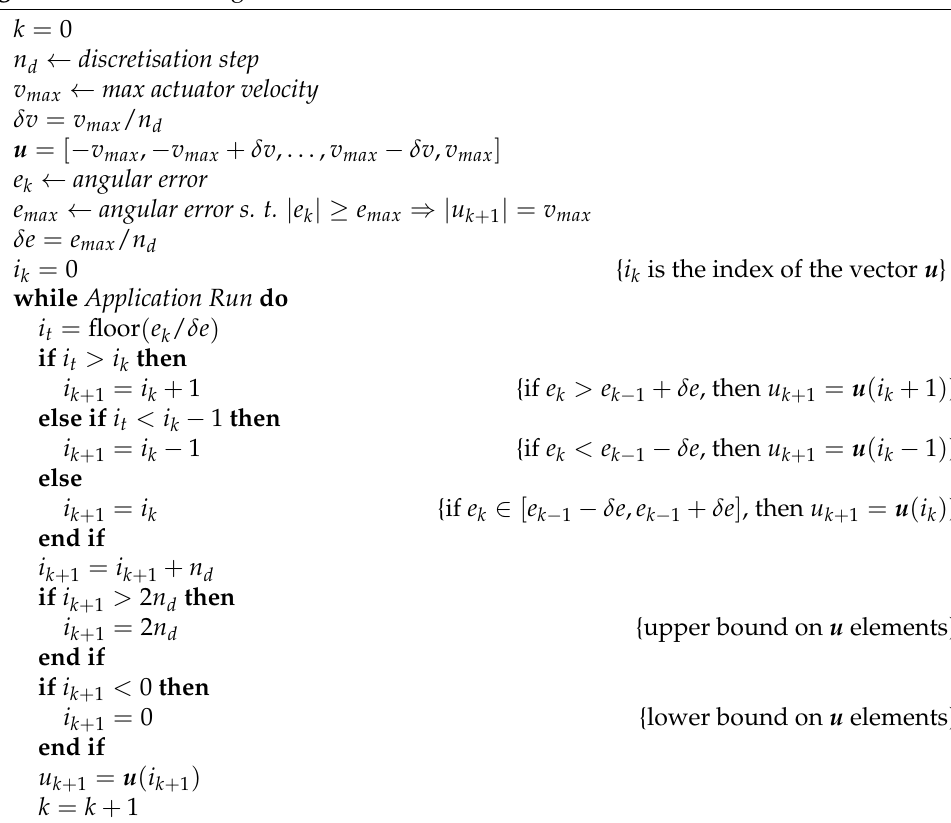
Figure 11. Control algorithm input output relation. Algorithm 1 Control